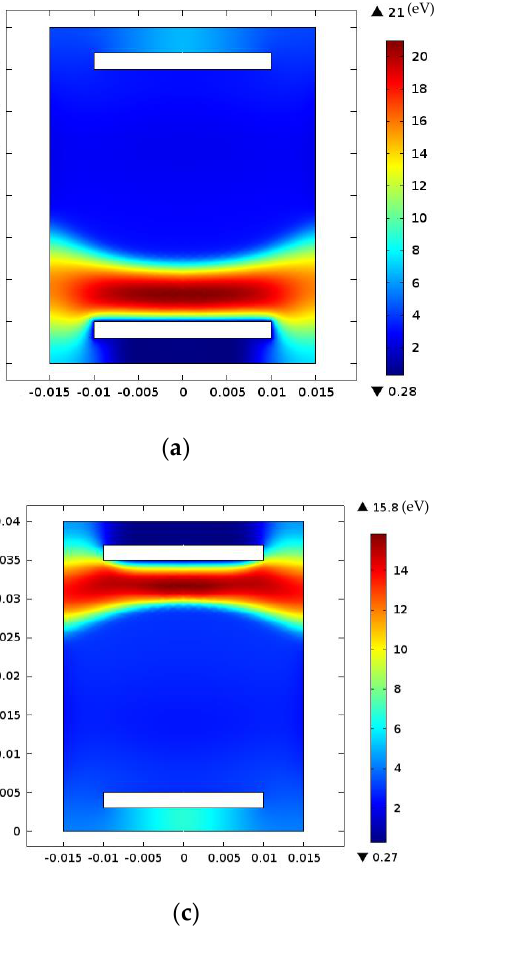
Figure 7. Electron temperature distribution at different instants of cycle RF (t) : (a) t = T /4, (b) t = T /2, (c) t = 3 T /4, and (d) t = T , at 0.3 Torr total gas pressure, RF voltage (150 V, 13.56 MHz), and 20% O 2 .